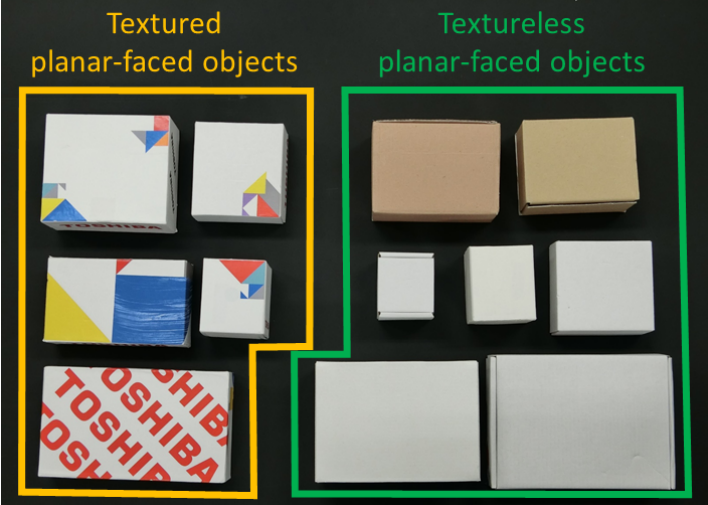
Figure 8. The object set. The yellow region indicates textured boxes. The green region indicates textureless boxes.